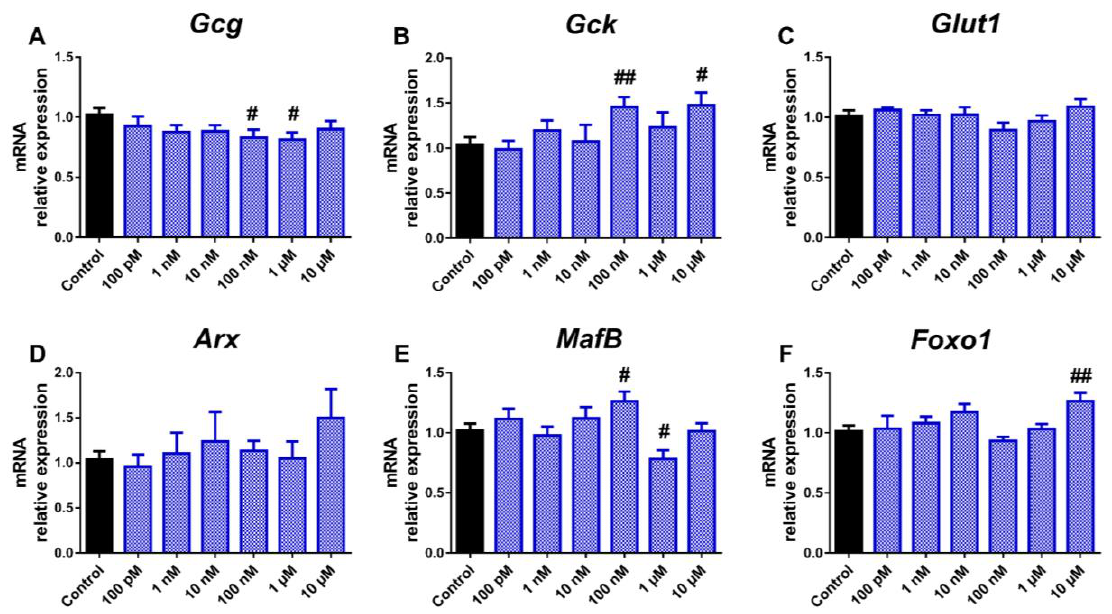
Figure 2. BPA effects on the expression of genes involved in pancreatic α -cell function and identity. mRNA expression of ( A ) Gcg , ( B ) Gck , ( C ) Glut1 , ( D ) Arx , ( E ) MafB , and ( F ) Foxo1 was measured in α TC1-9 cells treated for 24 h with different BPA concentrations (100 pM–10 µ M). Data are represented as mean ± SEM of n = 3–4 independent experiments. # vs. Control; # p < 0.05, ## p < 0.01 by the Student’s t test.